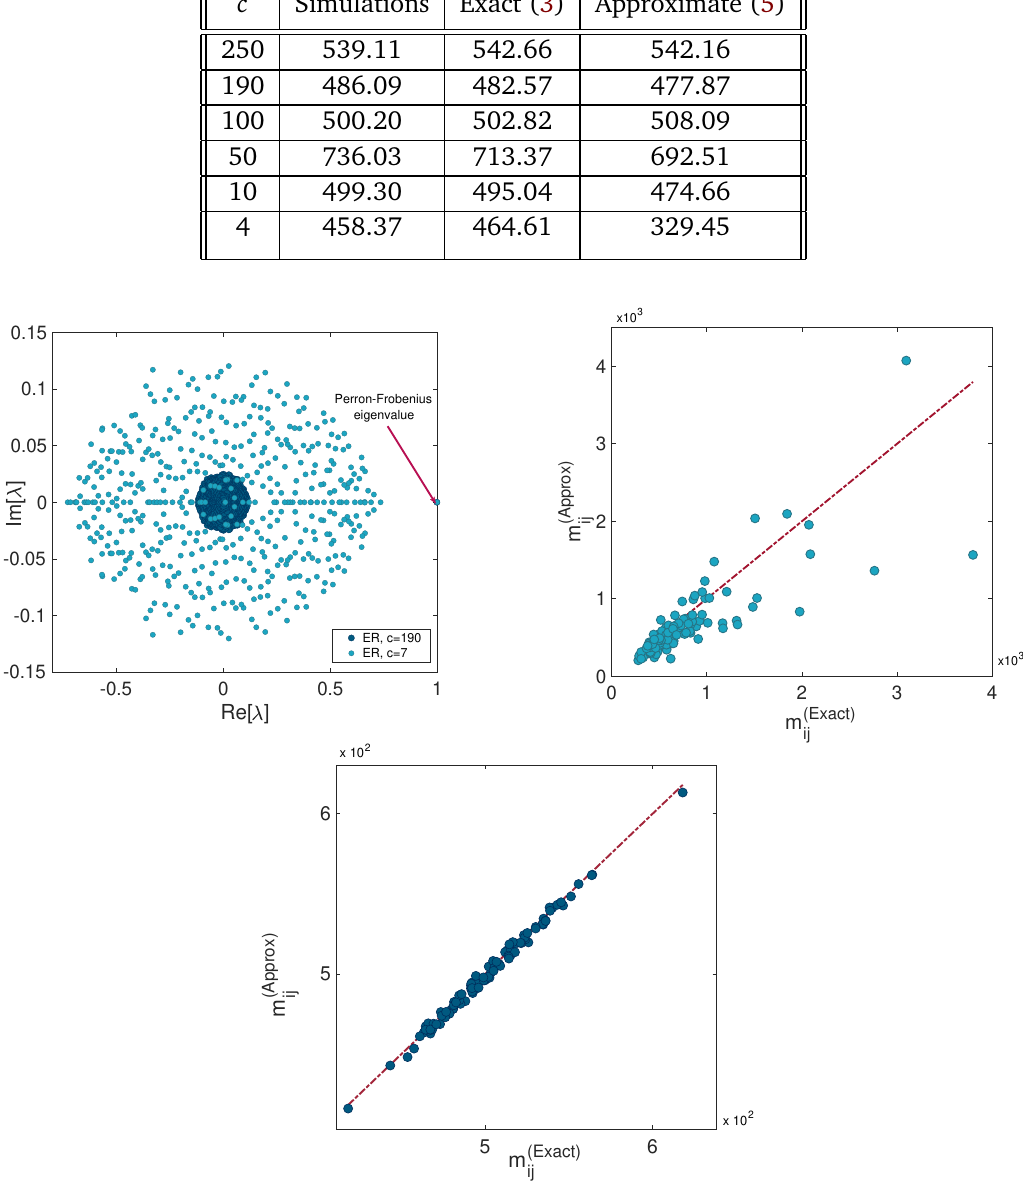
Figure 3: Top left: eigenvalues in the complex plane for a typical instance of T ( j ) for the Erd˝os-Rényi network described in section 3.2, with edge weights drawn from a uniform [ 0,1 ] distribution, and two values of c ( c = 190 (dark blue dots) and c = 7 (light blue dots)). Clearly the spectral gap is much narrower for the low- c case. Middle: scatter plot of exact results (obtained by matrix inversion, see eq. (3)) vs. our approximate formula in eq. (5). Each point (100 in total) refers to a randomly picked ( i , j ) (source-target) pair, on a randomly generated instance of the graph with N = 500 and c = 190. In dashed red, the straight line with slope = 1, indicating perfect agreement. Top right: same scatter plot as the middle panel, but with c = 7